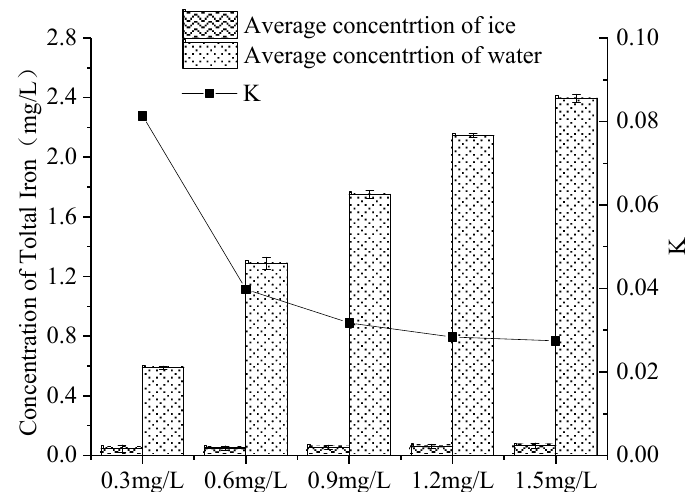
Figure 10. Distribution of iron with varying initial concentrations in the ice-water system. (Error bar: Mean ± S.D., K: the ratio of the average concentration of iron in the ice to that in the under-ice water).